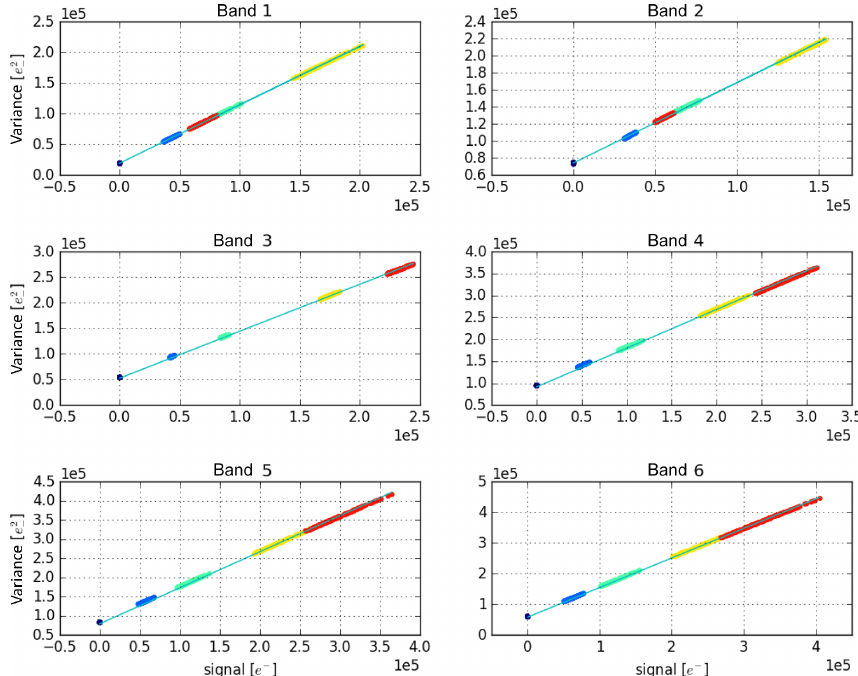
Figure 6. Signal versus variance for all UVN bands: signals and corresponding temporal variances, sorted and block-wise averaged for several dark and illuminated instrument settings. The shot noise law is clearly visible: all points are close to the overall regression line. Only slight residuals as functions of the signal magnitudes seem to